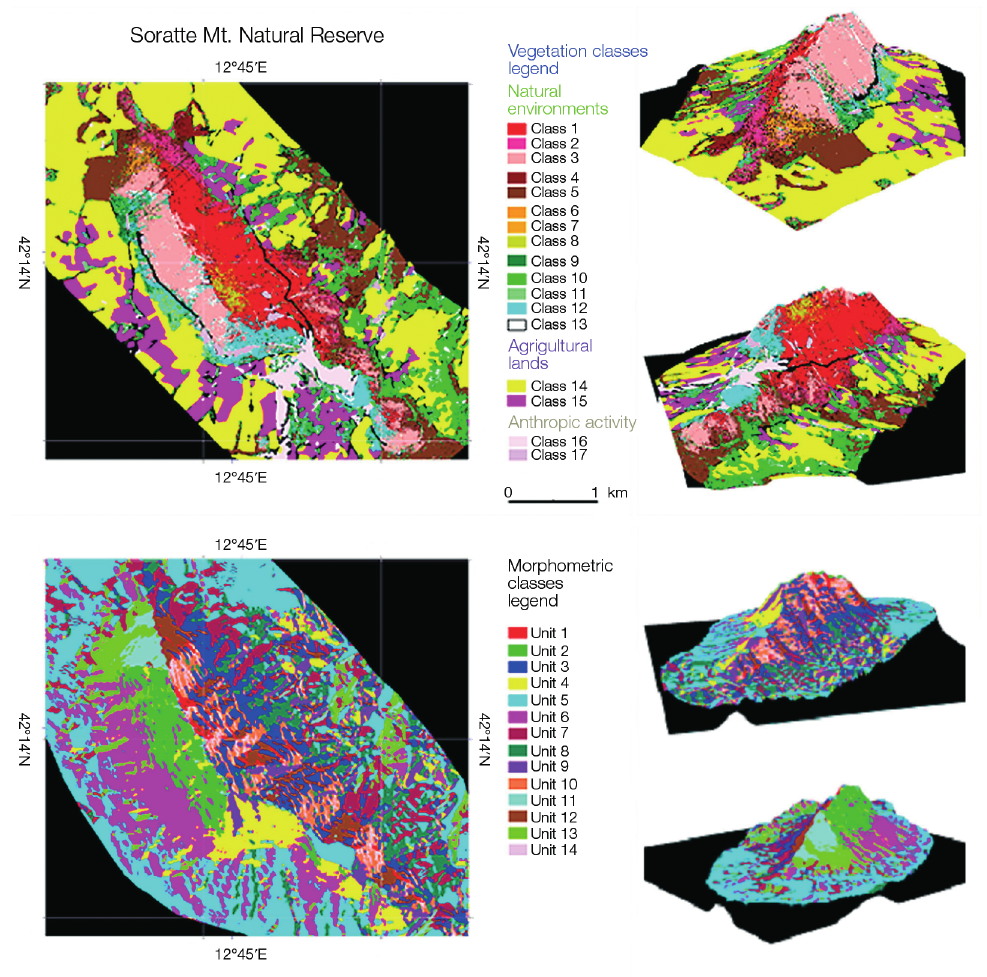
Fig. 3. Top left : map showing the prevailing vegetation classes on Soratte Mt. as derived from the ML classifi- cation. Top right : two 3D perspective views of the vegetation classes map, draped over the DEM: in the former (down) the view is from South to North, in the latter (up) from north to south. Bottom left : map showing the re- sults of the ISODATA classification. Bottom right : two 3D views of the morphometric units map, draped over the DEM: in the former (down) the view is from north to south, in the latter (up) from south to north. Vertical exaggeration of the 3D views is 2 to better enhance the overall